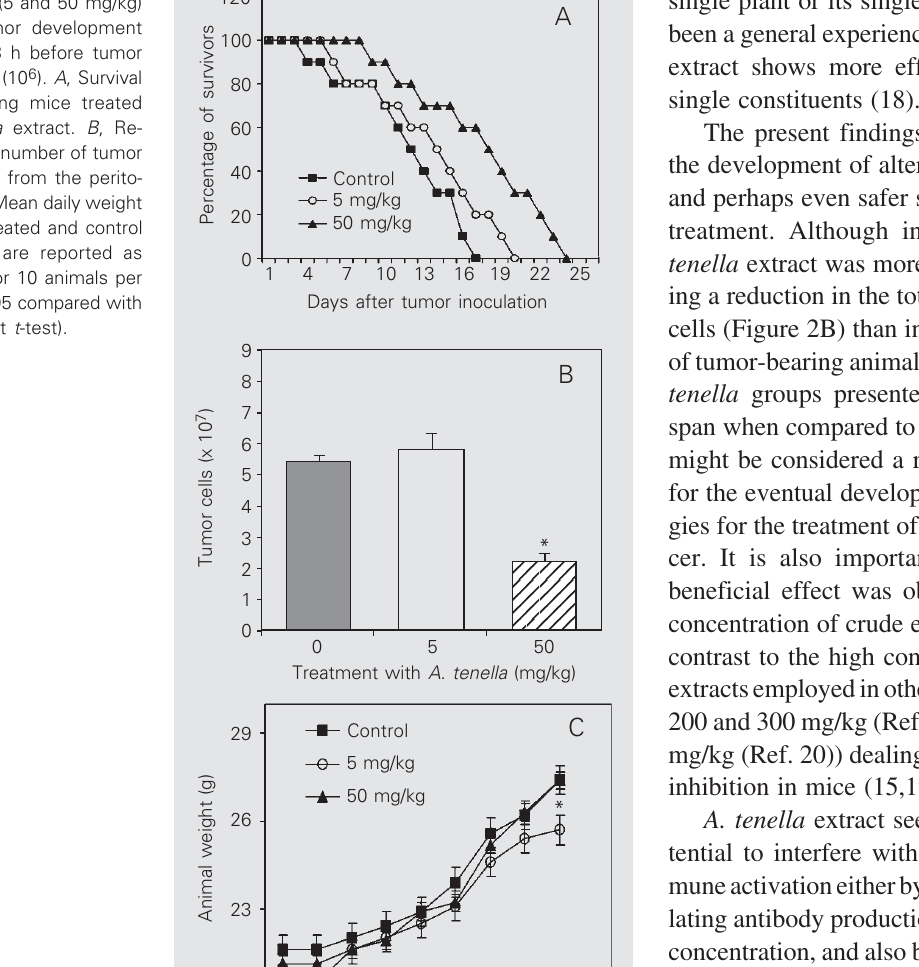
Figure 2. Effect of Alternanthera tenella extract (5 and 50 mg/kg) on Ehrlich tumor development when given 48 h before tumor cell inoculation (10 6 ). A , Survival of tumor-bearing mice treated with A. tenella extract. B , Re- duction in total number of tumor cells recovered from the perito- neal cavity. C , Mean daily weight of A. tenella -treated and control animals. Data are reported as means ± SD for 10 animals per group. *P < 0.05 compared with control (Student t